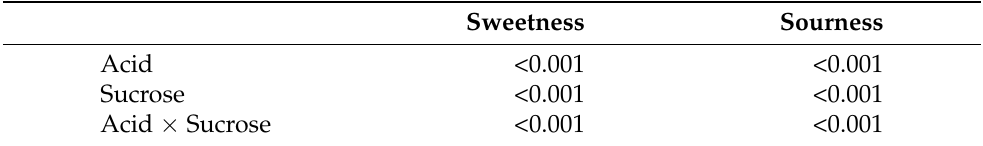
Table 4. p -values for ANOVA model of aqueous matrix.